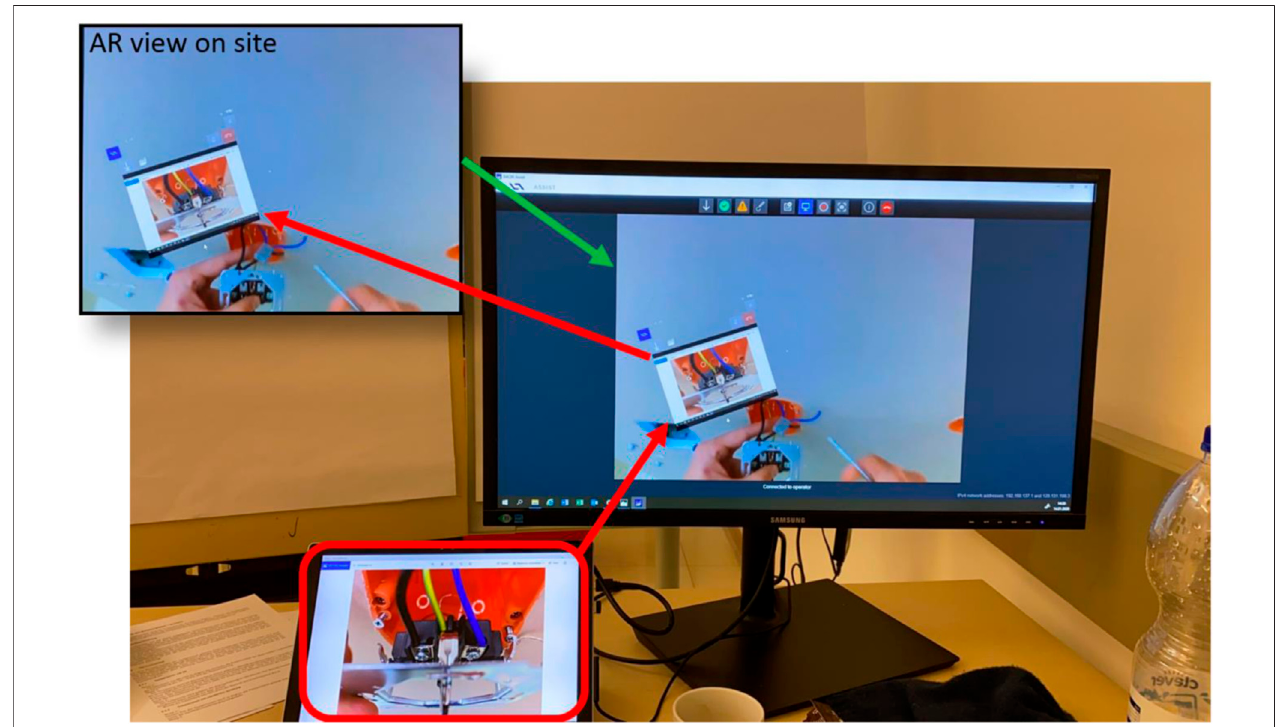
FIGURE 6 | Remote site inspection with Remote Expert System. Reprinted from Schranz et al. (2020), fi g. 3, p. 382.